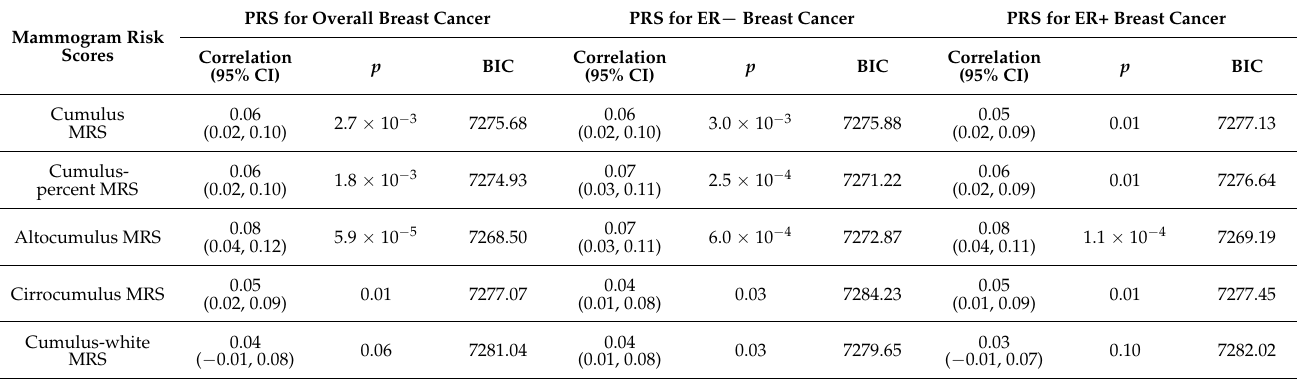
Table 2. Correlations between mammogram risk scores and breast cancer polygenic risk scores.